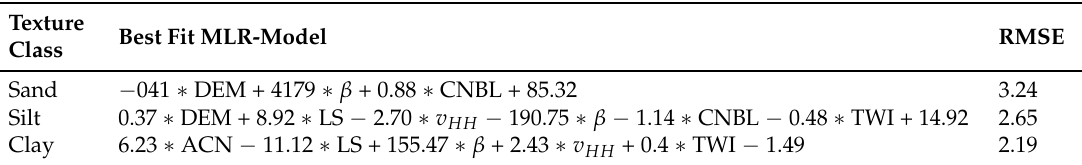
Table 3. Fitting results of the deterministic term of Equation (7) in terms of regression equations. Meanings of the abbreviations are explained in Sections 2.4 and